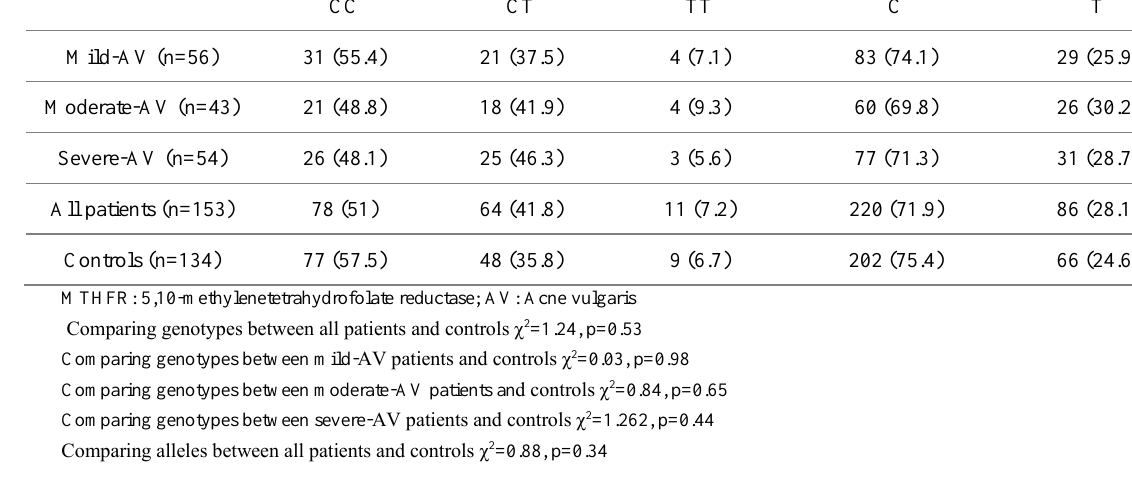
Table 4. Comparison of the frequency of MTHFR genotypes and alleles between patients with mild-, moderate-, and severe-AV and controls MTHFR Groups